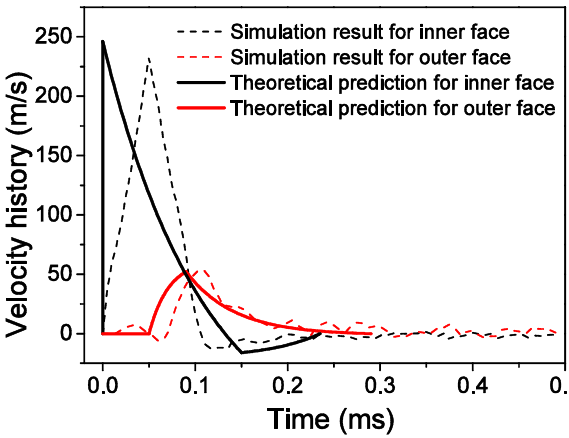
Figure 15. Comparison of face-sheet velocities between theoretical predictions and FE results.